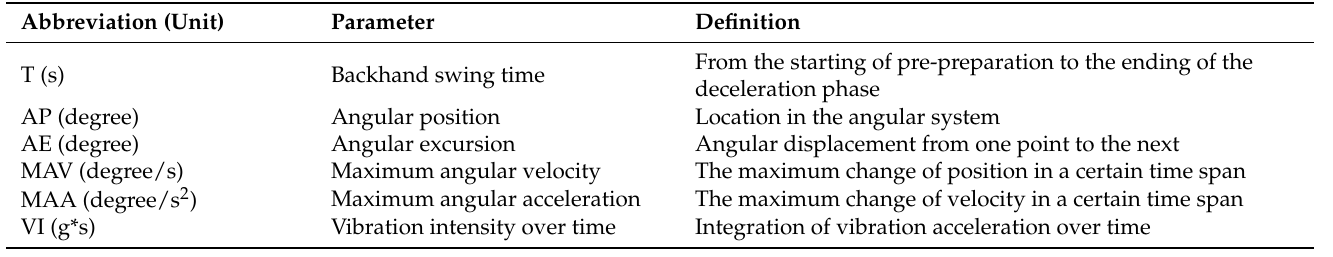
Table 2. Definition of the measuring parameters.